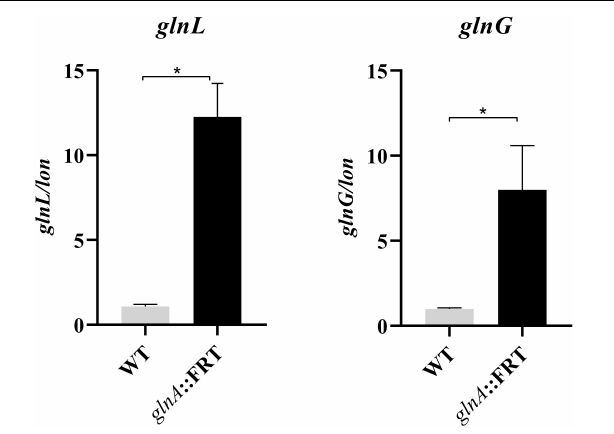
FIGURE 5 | Expression level of glnL and glnG transcripts in the mutant glnA ::FRT compared to WT strain. Expression of transcripts was normalized to the expression of lon and compared to the expression of glnL or glnG in the of WT strain. Results are average of at least three biological replicates. Asterisks indicate significance, calculated by Student’s t -test, of results liked by brackets. * p ≤